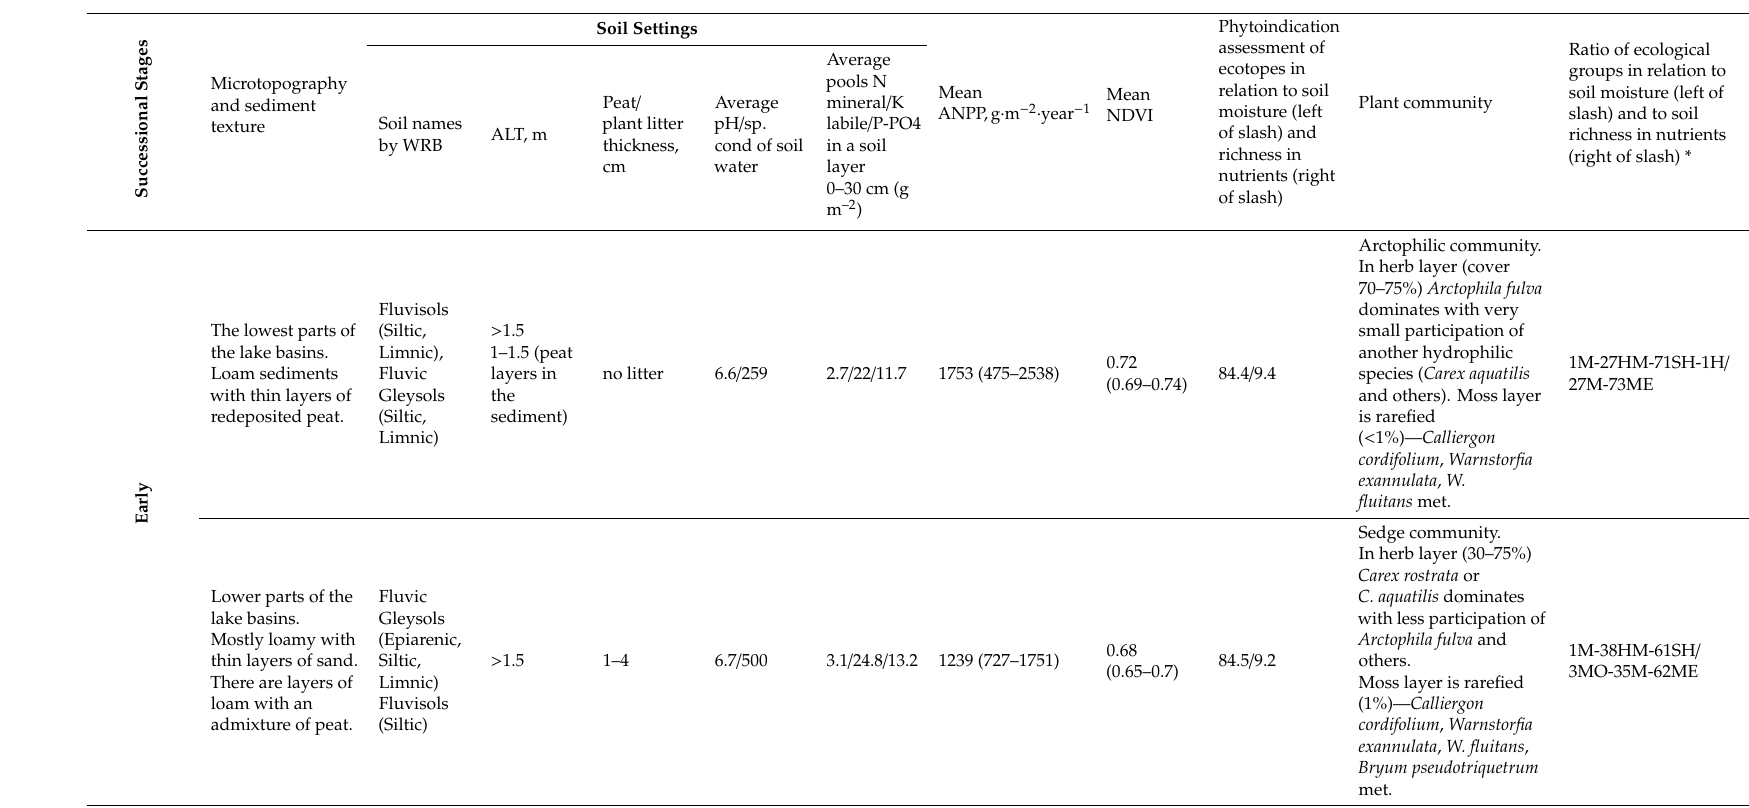
Table A2. Successional stage of khasyrey, microtopography and soil settings and dominant plant species of each ecosystem.